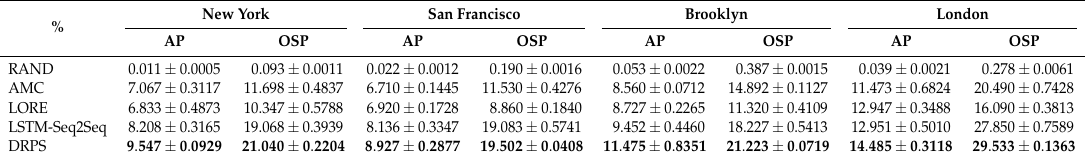
Table 3. Performance comparison on four cities in terms of AP and OSP under the setting where the input and output lengths are, respectively, 25 and 10. The numbers in bold face indicate the ones with the best performances.